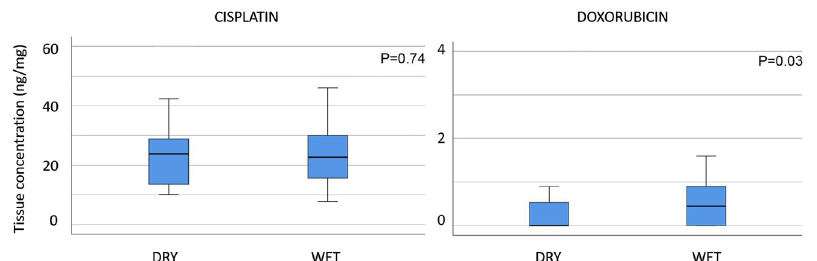
Figure 3: Influence of the pre-analytical probe processing on tissue drug concentration. Tissueconcentrationofcisplatin(leftpanel) does not depend on prior dabbing of the surface. In contrast, this manoeuvre influences doxorubicin concentration (right